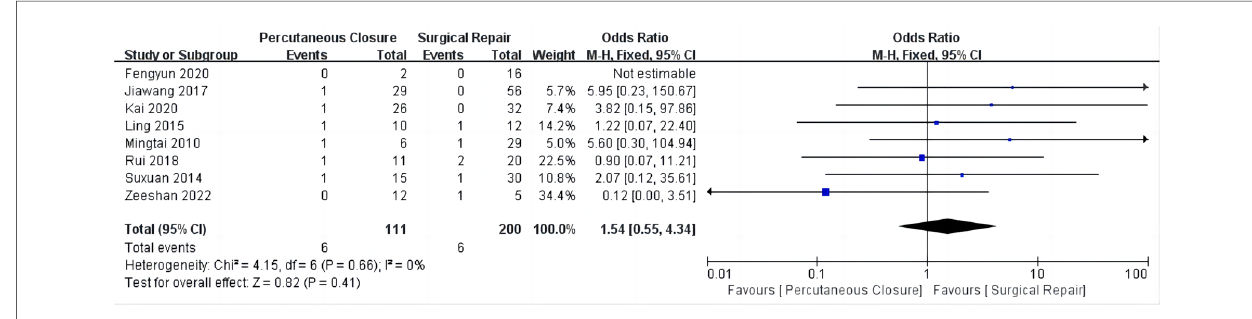
FIGURE 3 Comparison of postoperative residual shunt rates between percutaneous closure and surgical repair.